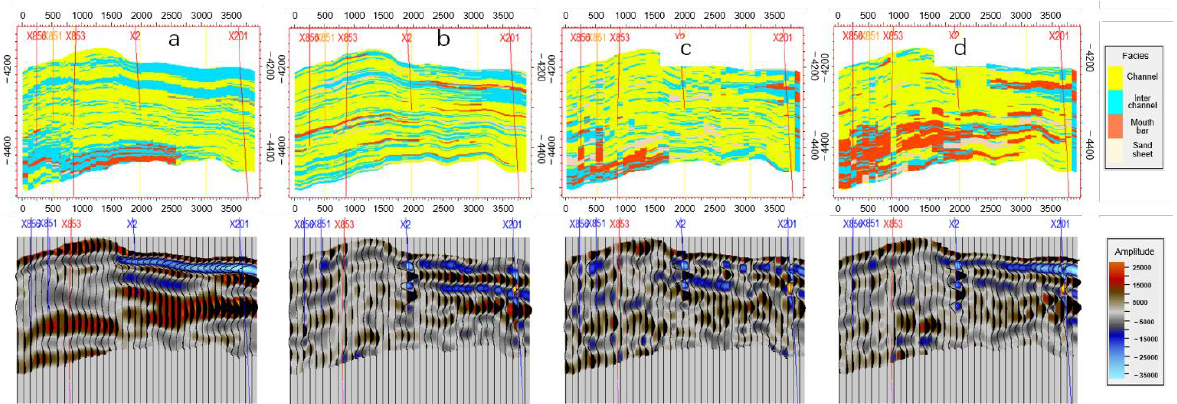
Figure 17. Training image and lithofacies model inversions obtained using the different methods and forward simulation records of well X853 through the drainage: ( a ) Training image, ( b ) TPI lithofacies model, ( c ) MPI lithofacies model, and ( d ) LPUMI lithofacies model.